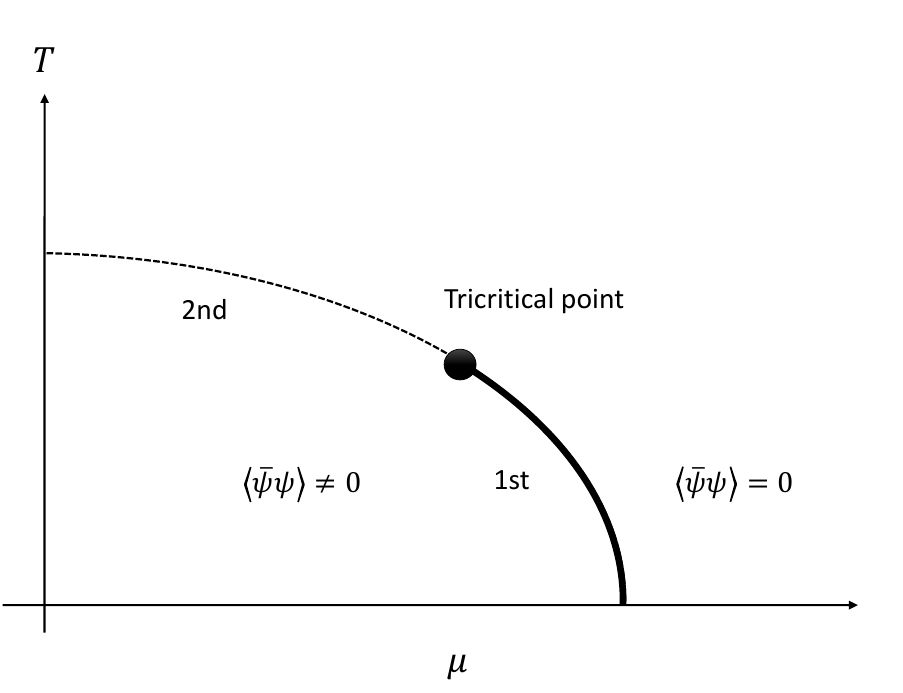
Figure 1 . Schematic view of expected phase diagram of the NJL model on the T - µ plane. Solid and broken curves represent the first- and second-order phase transitions, respectively. Closed circle denotes the tricritical point where the first-order phase transition line